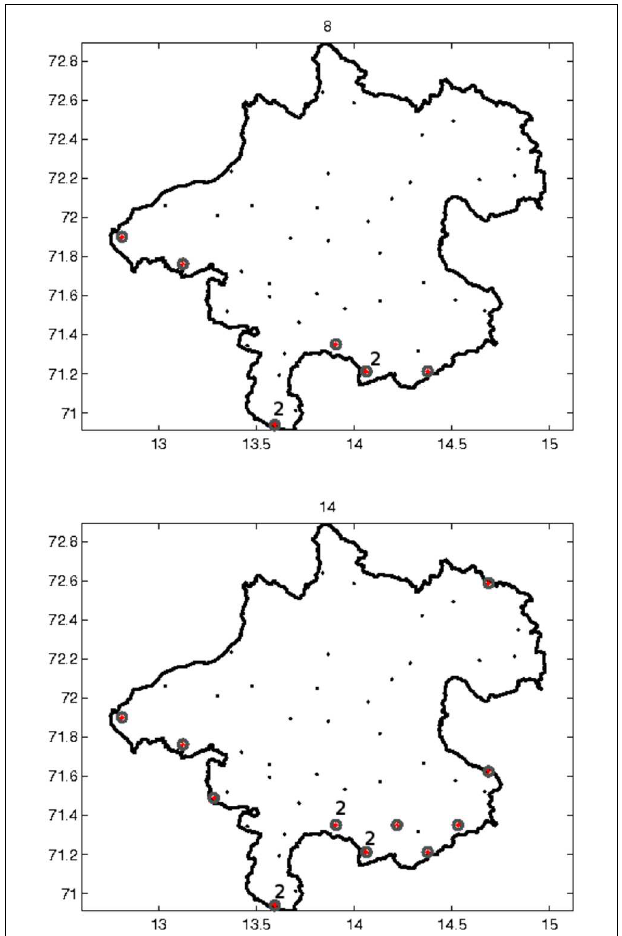
FIGURE 11 | Above: Optimal 8 point design for trans-Gaussian kriging. Below: Optimal 14 point design for trans-Gaussian kriging. Certain locations have been selected with multiplicities larger than 1. Red dots: Sampling locations